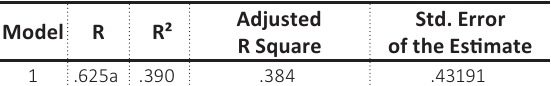
Table 6. Hypothesis 2 testing